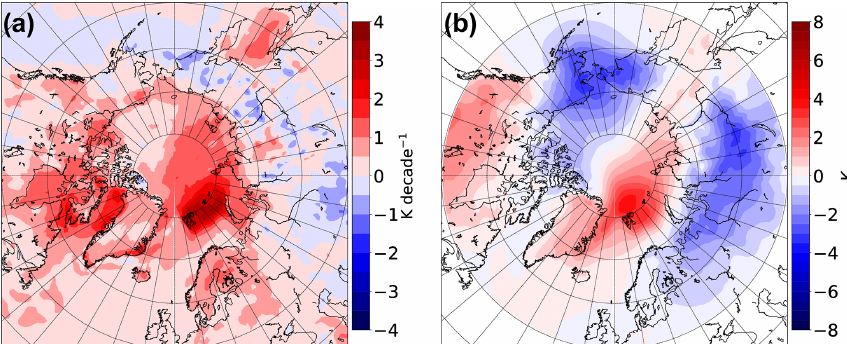
Figure 7. (a) 2m temperature trends for the winter mean, calculated for the winters from 1979/80 to 2015/16. Trends are given in kelvin per decade. (b) Composite of 2m temperature anomalies from the North Atlantic pathway and the negative of the North Pacific pathway temperature anomalies as provided in Fig. 3, weighted by their relative frequency of occurrence (Fig. 2 top right numbers).